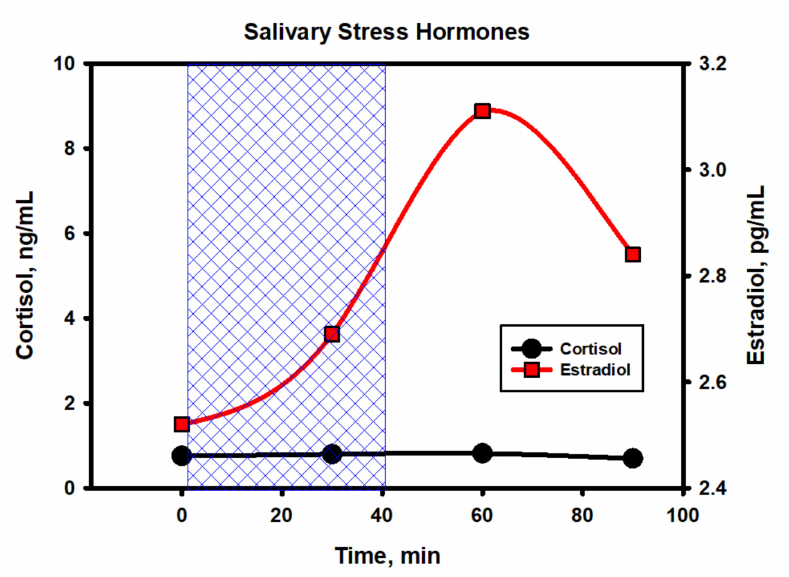
Figure 16. Fluctuations of the stress hormones cortisol and estradiol levels in the saliva of a volunteer during the testing period of a 4-mg nicotine pack. The upper limits of the physiological norms of both hormones, taking into account the time of day, gender and age of the subject, are 2.2 ng/mL and 4.6 pg/mL for cortisol and estradiol,